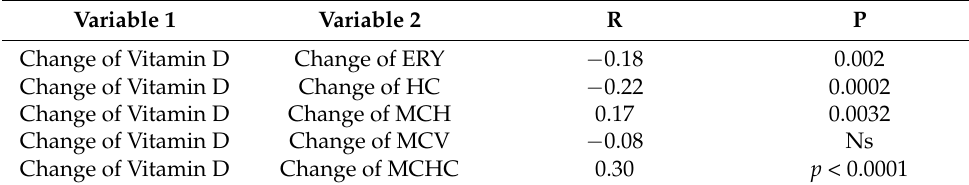
Table 3. Correlation analysis between 25-(OH)-vitamin D blood concentrations and blood